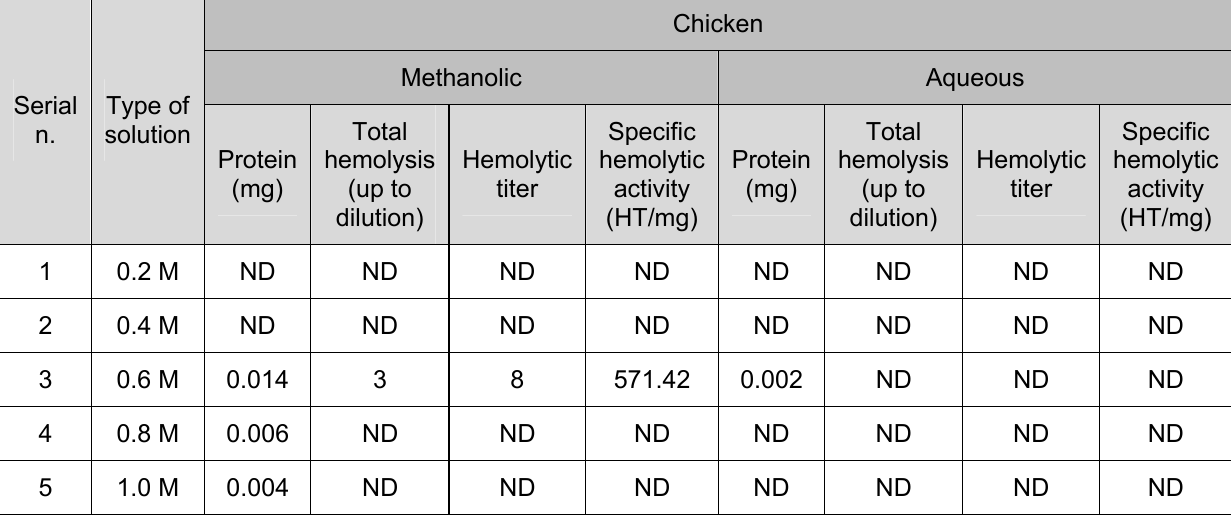
Table 2. Hemolytic activity of methanolic and aqueous fractions of Halichondria panicea on chicken erythrocytes Chicken Methanolic Aqueous Serial Type n.